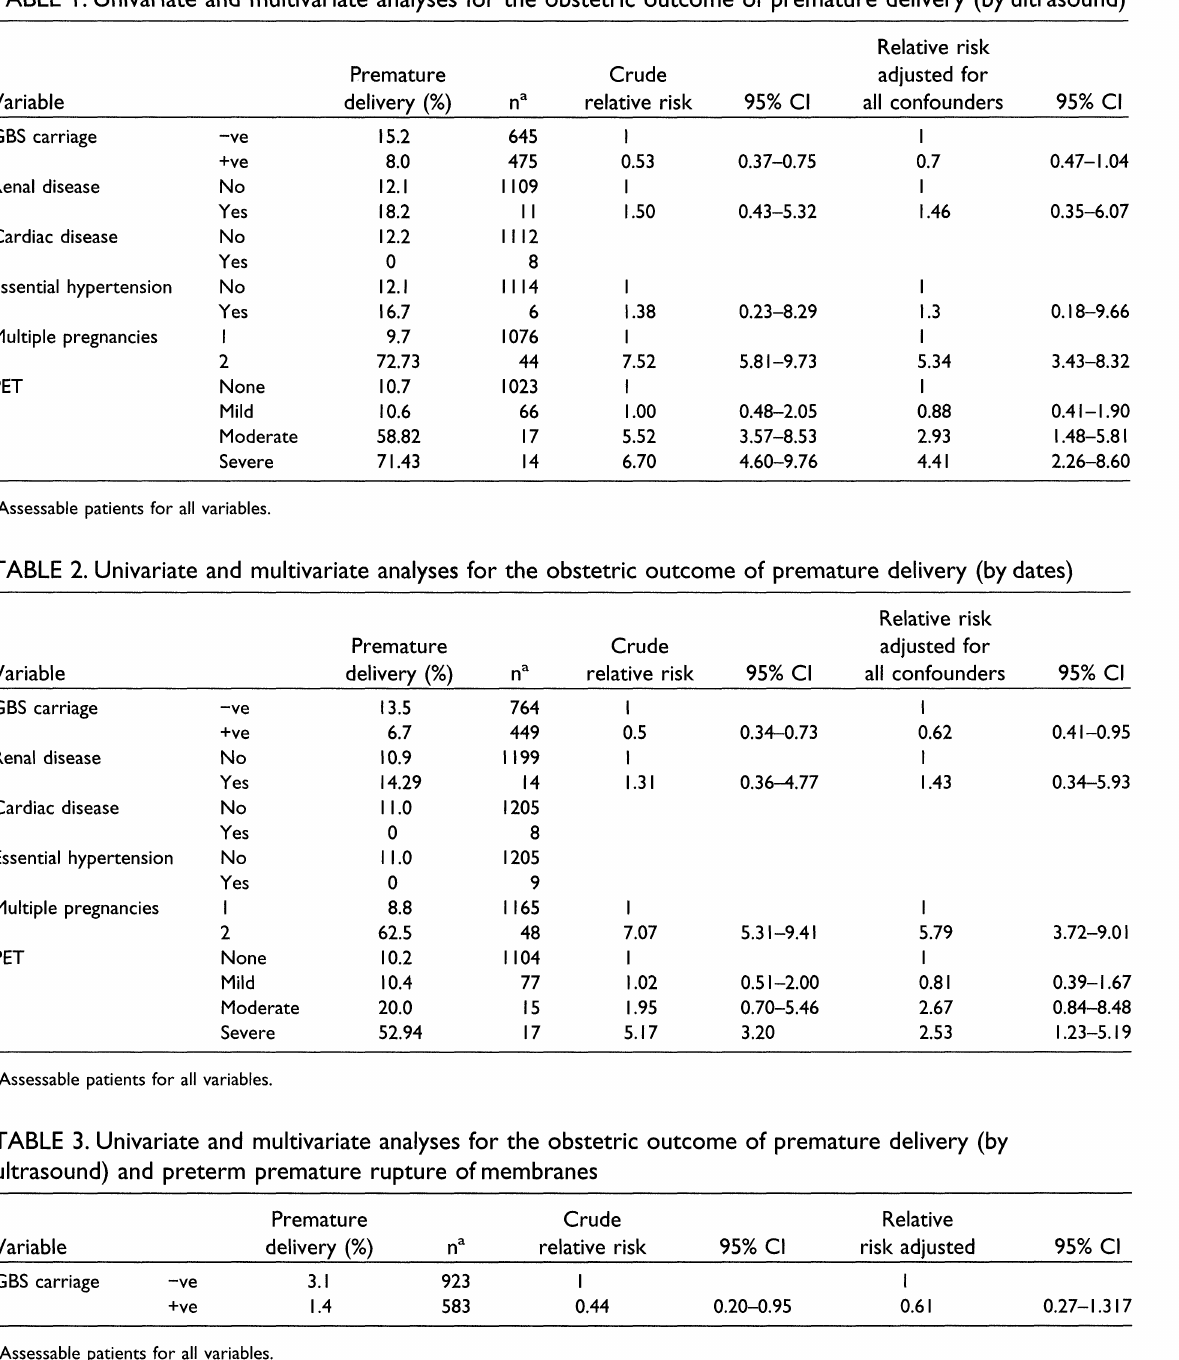
TABLE I. Univariate and multivariate analyses for the obstetric outcome of premature delivery (by ultrasound) Relative risk Premature Crude adjusted for Variable delivery (%) n relative risk 95% CI all confounders 95% CI